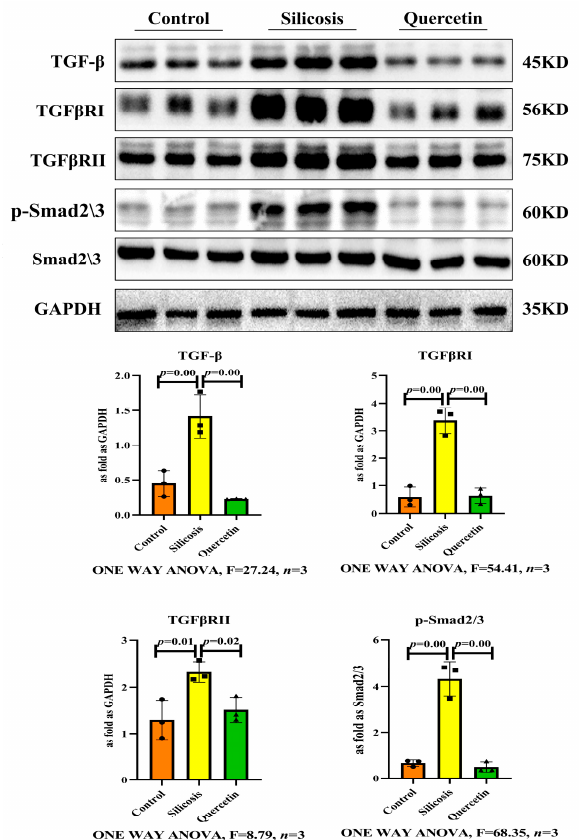
Figure 13. The expressions of TGF- β , TGF β RI, TGF β RII, and p-Smad 2/3 in SiO 2 -treated MH-S, measured by Western blot. Data are presented as the mean ± SD, n = 3 per group.